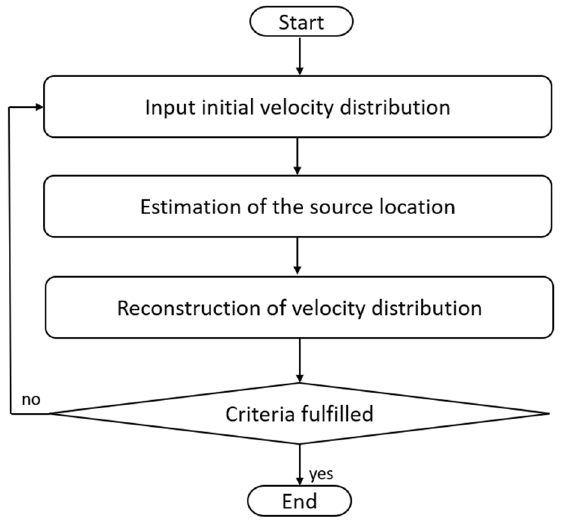
Figure 1. Flowchart of AE tomography.